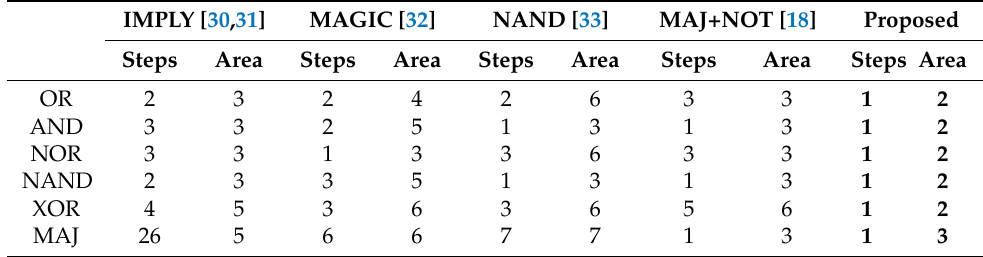
Table 5. Resources required for individual logic gates using different in-memory logic approaches. IMPLY [30,31]